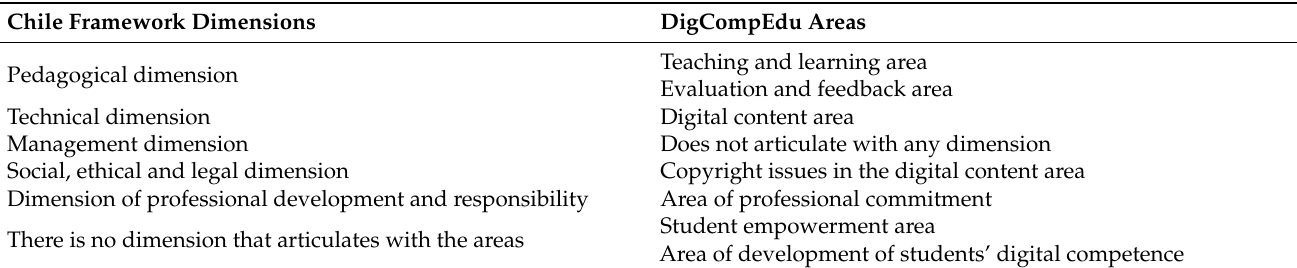
Table 11. Comparison of Chile and DigCompEdu